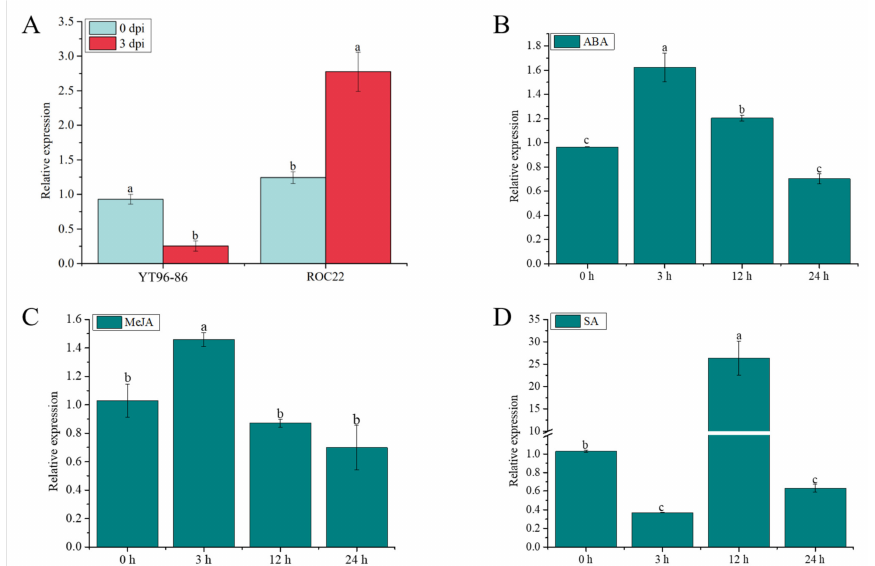
Figure 10. Expression of the ScGH3-1 gene under S. scitamineum , ABA, SA, and MeJA stresses. ( A ) Expression of ScGH3-1 gene in the interaction between sugarcane and S. scitamineum . ( B – D ) Expressionof ScGH3-1 gene under ABA, MeJA, and SA stresses. Data were normalized to the glyceraldehyde-3-phosphate dehydrogenase (GAPDH) expression level. All the data points are means ± standard deviation ( n = 3). Bars superscripted by different lower-case letters indicate significant differences, as determined by Duncan’s new multiple-range test ( p -value <